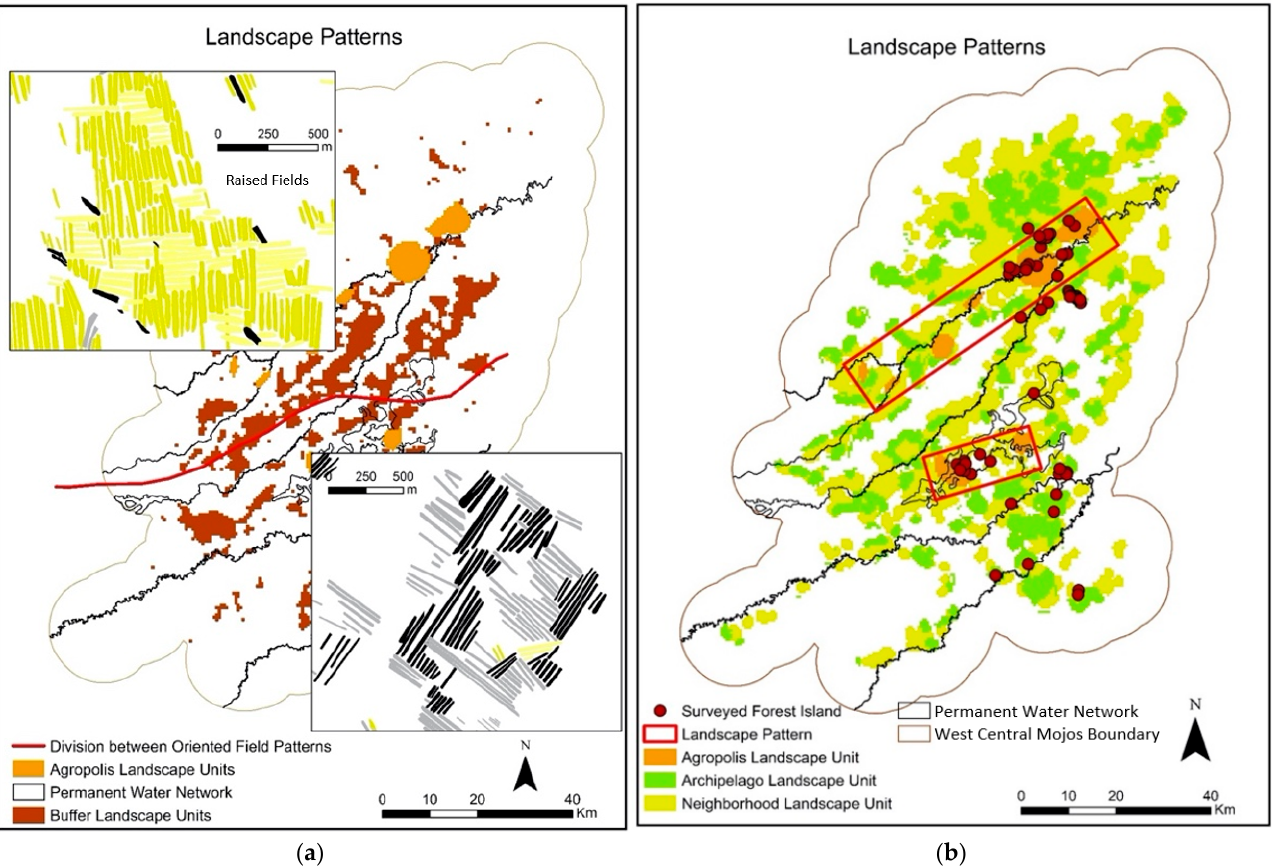
Figure 8. ( a ) The transitional zone between regional settlement patterns coincides with a transition between dominant field orientations identified by Lee [59]. North of the division, fields are commonly oriented on a north/south or east/west axis (fields shaded yellow). In the southern region fields are commonly oriented on a northeast/southeast or northwest/southwest axis (fields shaded black and grey). ( b ) A map showing 55 forest islands that have been ground surveyed.